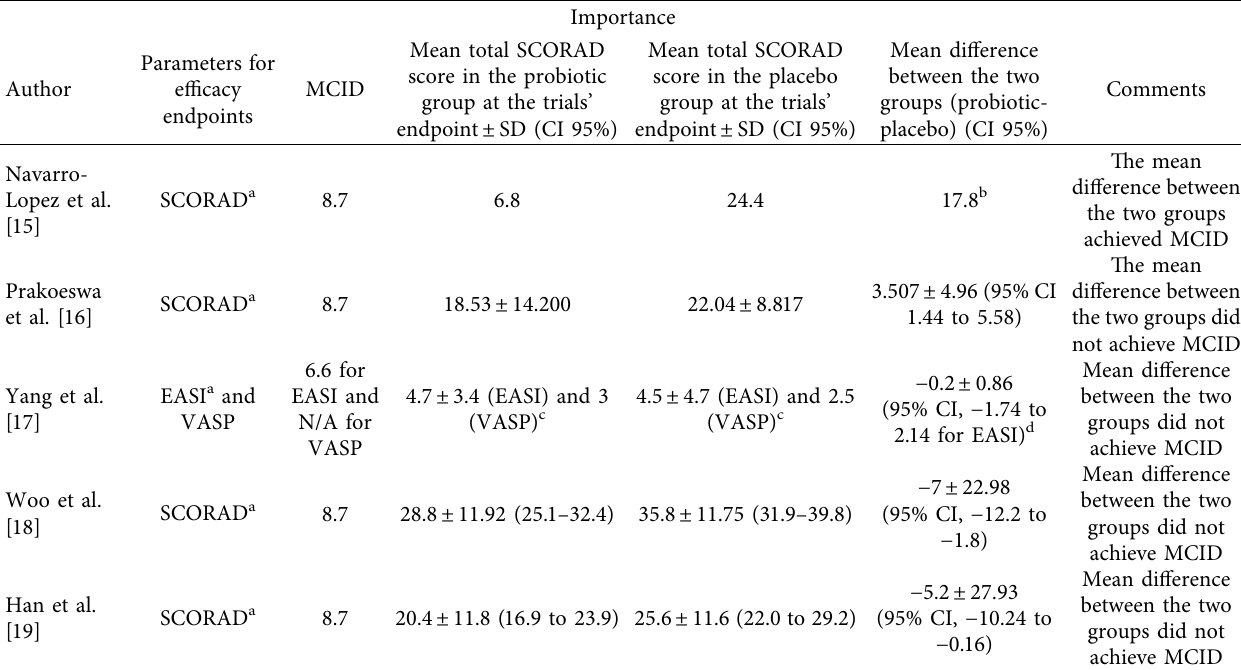
Table 3: Importance appraisal of RCTs based on CEBM critical appraisal tools.